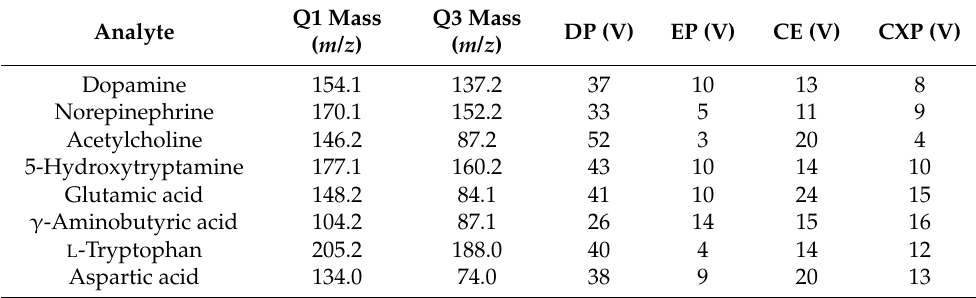
Table 1. List of multiple reactions monitoring parameters, declustering potential (DP), entrance potential (EP), collision energy (CE) and cell exit potential (CXP) for each analyte and isoproterenol hydrochloride